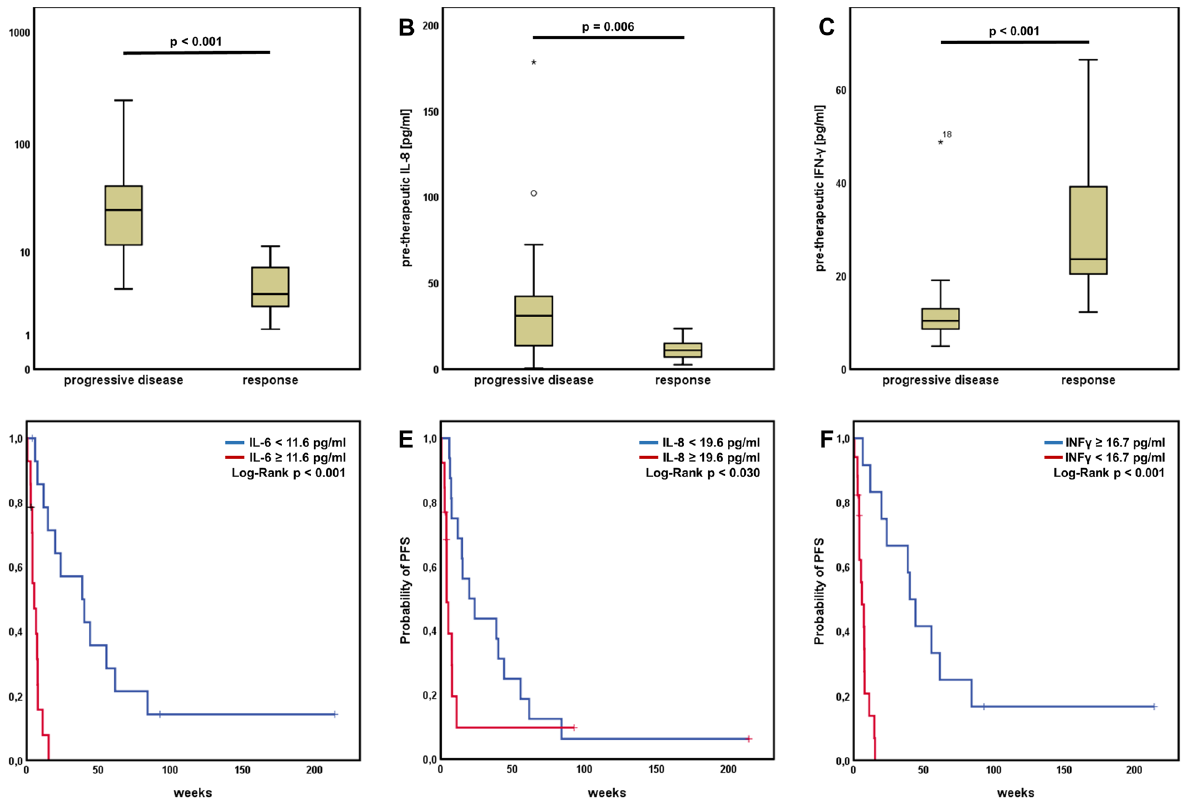
Figure 2. Pre-therapeutic cytokine levels predict response and survival. Patients with initial response showed significantly lower levels of ( A ) interleukin 6 (IL-6), ( B ) interleukin 8 (IL-8) or elevated levels of ( C ) interferon gamma (IFN-γ). PFS was significantly longer in patients with lower IL-6 ( D ), lower IL-8 ( E ) and higher IFN-γ ( F ).